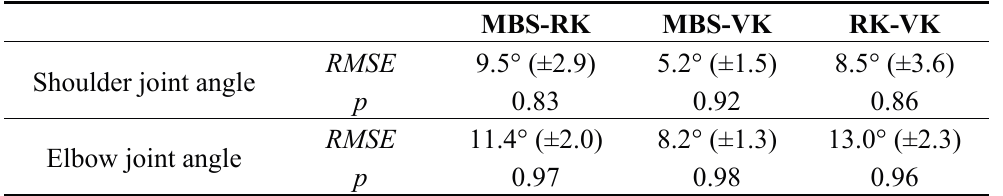
Table 1. Root mean square error ( RMSE ) is expressed in degree (st. dev.), p = Pearson coefficient of